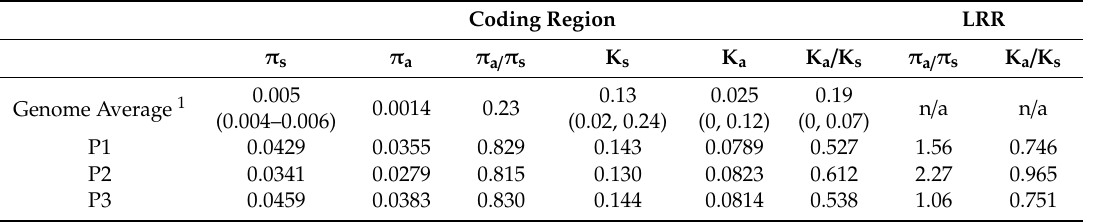
Table 4. Within-paralog synonymous and nonsynonymous nucleotide diversity ( π ) and divergence (K) for the entire coding region and the leucine-rich repeat region